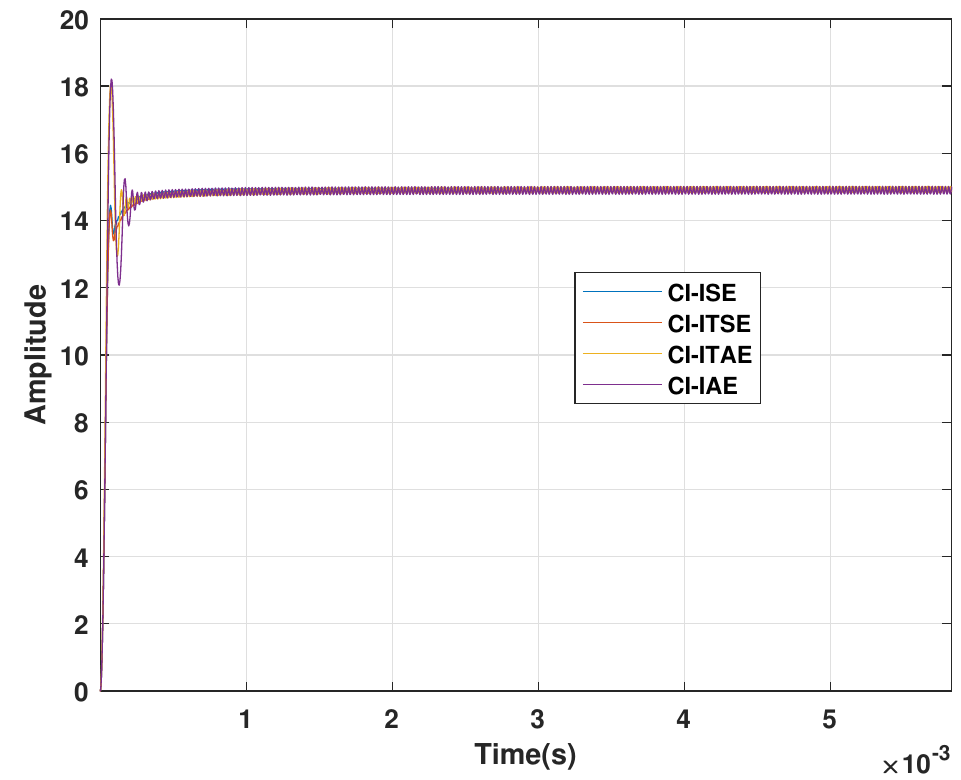
Figure 7. CI-optimized system responses for different cost functions.